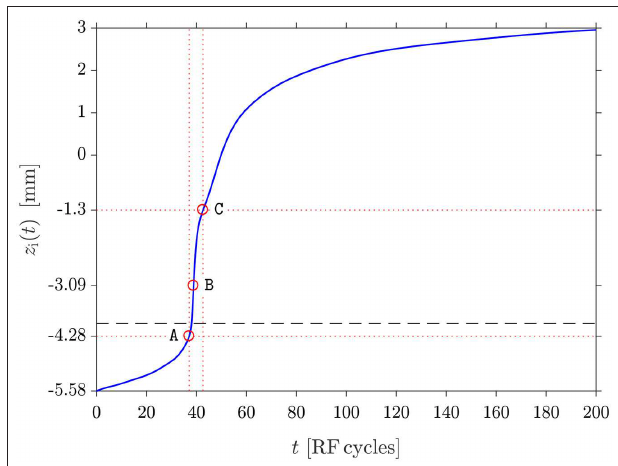
FIGURE 5 | Runge-Kutta analysis of ion transit path across the DL potential structure (points A , B , and C defined on Figure 3 ) for the 0.1Torr outlet pressure DL simulation. The vertical and horizontal dotted red lines are visual guides. The dashed horizontal line corresponds to the nozzle throat, i.e., end of the RF electrode ( Figure 2